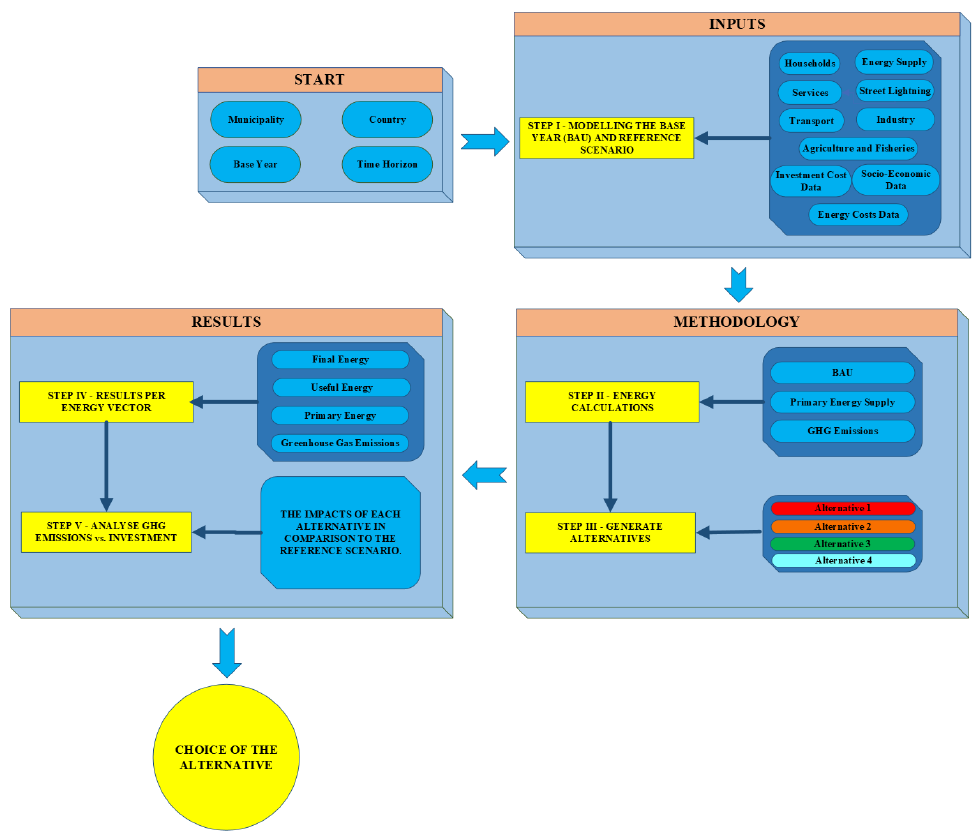
Figure 5. Flowchart of the functioning of the Local Energy Planning Assistant